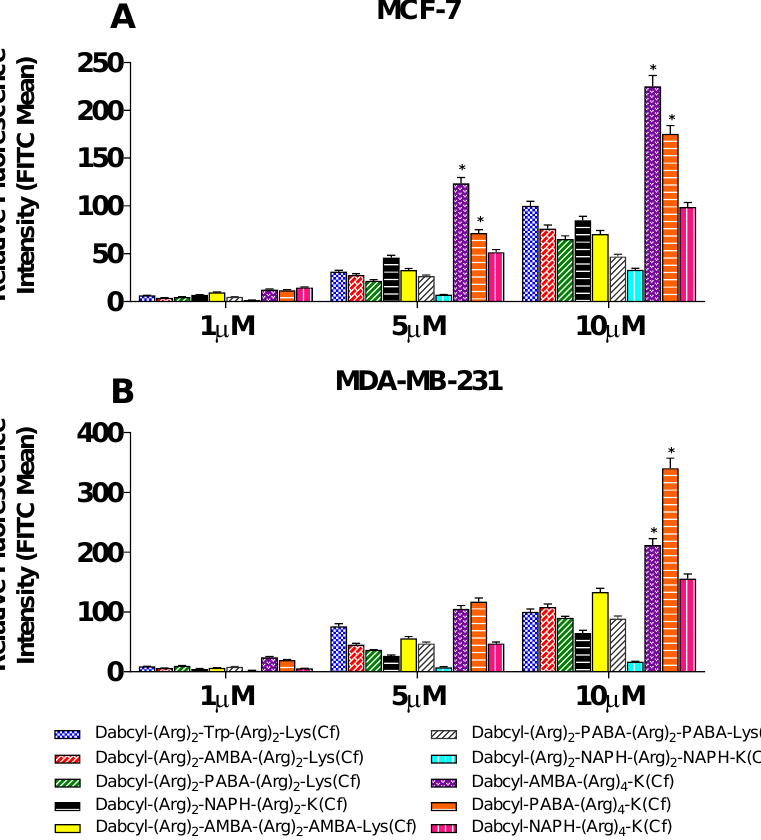
Figure 2. Cellular uptake of peptides on MCF-7 ( A ) and MDA-MB-231 ( B ) cells. Cells were treated with 1, 5 and 10 µ M peptide solution for 90 min. The fluorescence intensity of the cells was deter- mined by flow cytometry after trypsin treatment. The fluorescence intensity is relative to Dabcyl- RRWRRK(Cf) at 10 µ M (100%). Differences between the peptides (Dabcyl-AMBA-RRRR-K(Cf) and Dabcyl-PABA-RRRRK(Cf)) and Dabcyl-RRWRRK(Cf) were determined by Student’s t test (* p < 0.05). Data represents the mean ± standard deviation (SD).